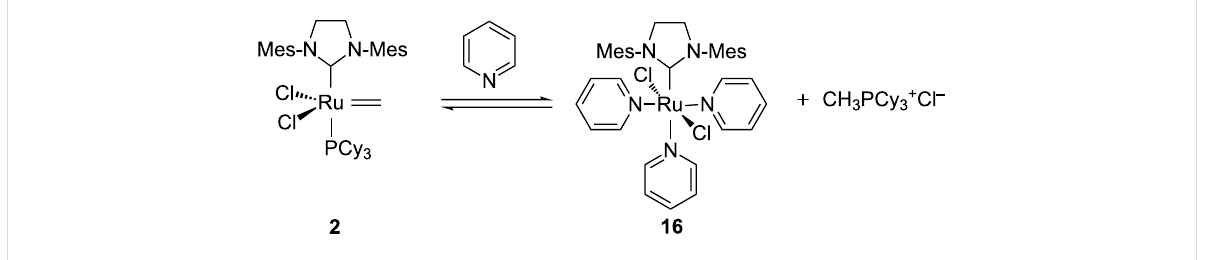
Scheme 7: Deactivation of methylidene 2 in the presence of